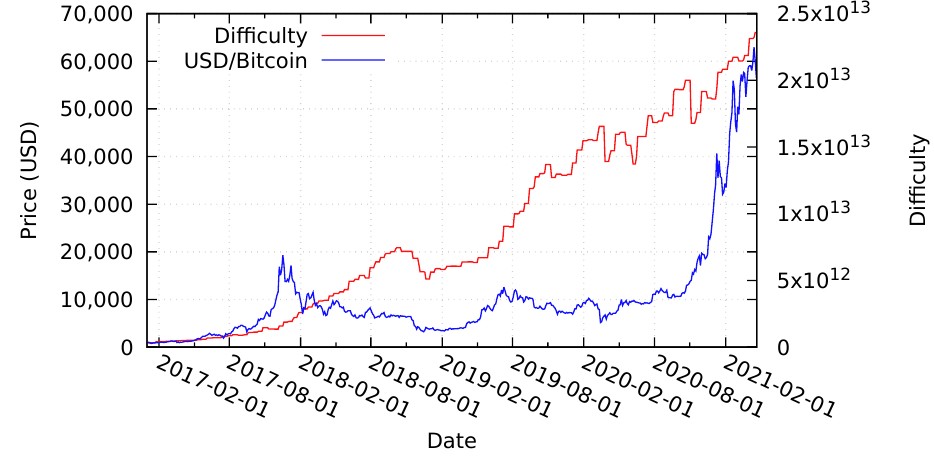
Figure 9. Average daily price of Bitcoin in USD and block difficulty level between January 2017 and April 2021—partially based on [5,15], Data Source